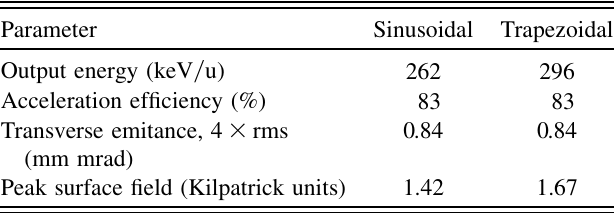
TABLE III. Comparison between the original sinusoidal and final trapezoidal modulation design for the ATLAS upgrade RFQ for the same voltage and power.